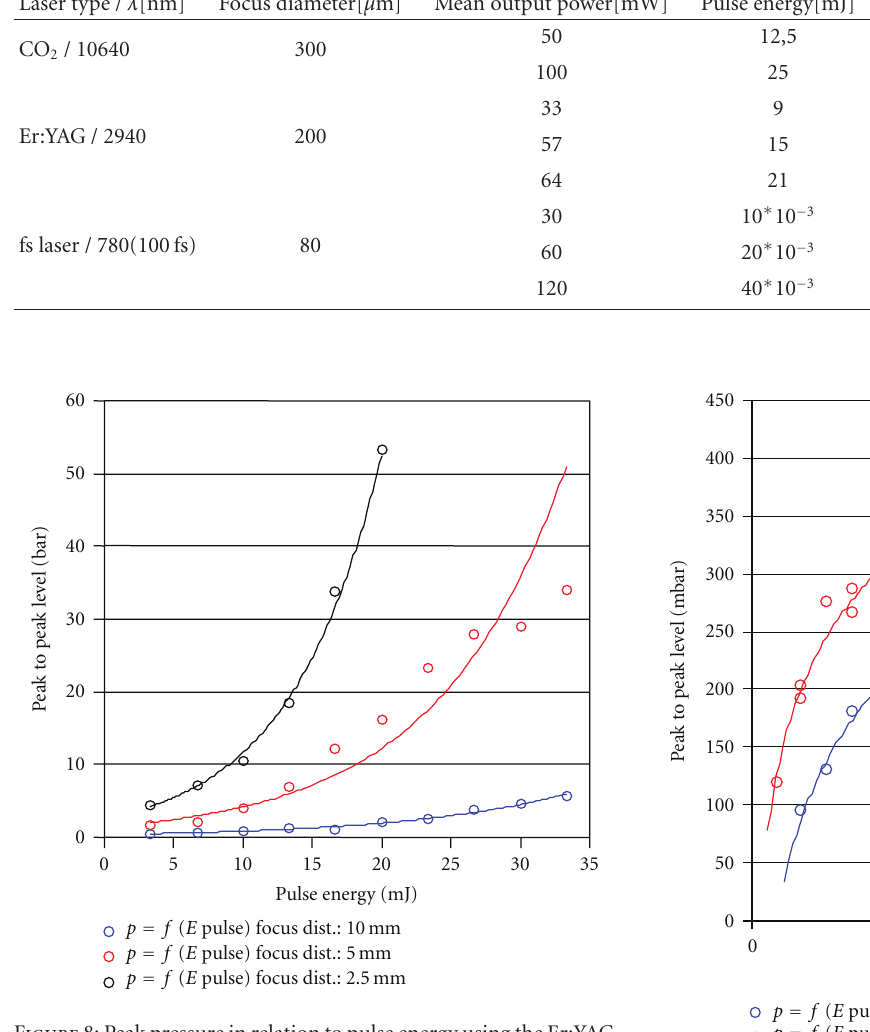
Figure 8: Peak pressure in relation to pulse energy using the Er:YAG laser, at varying focal distance from the measuring element.